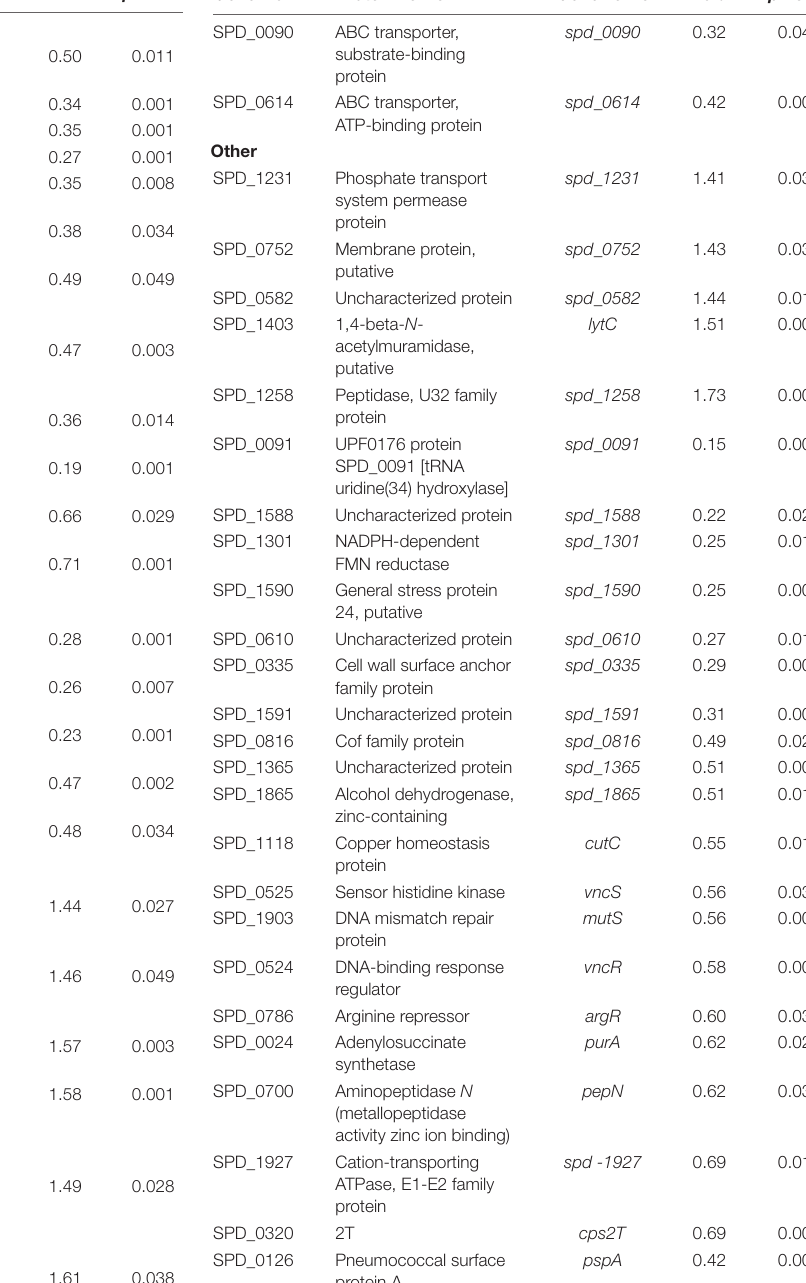
TABLE 3 | Differentially expressed proteins identified in D39 (cid:49) spd0090 . Gene